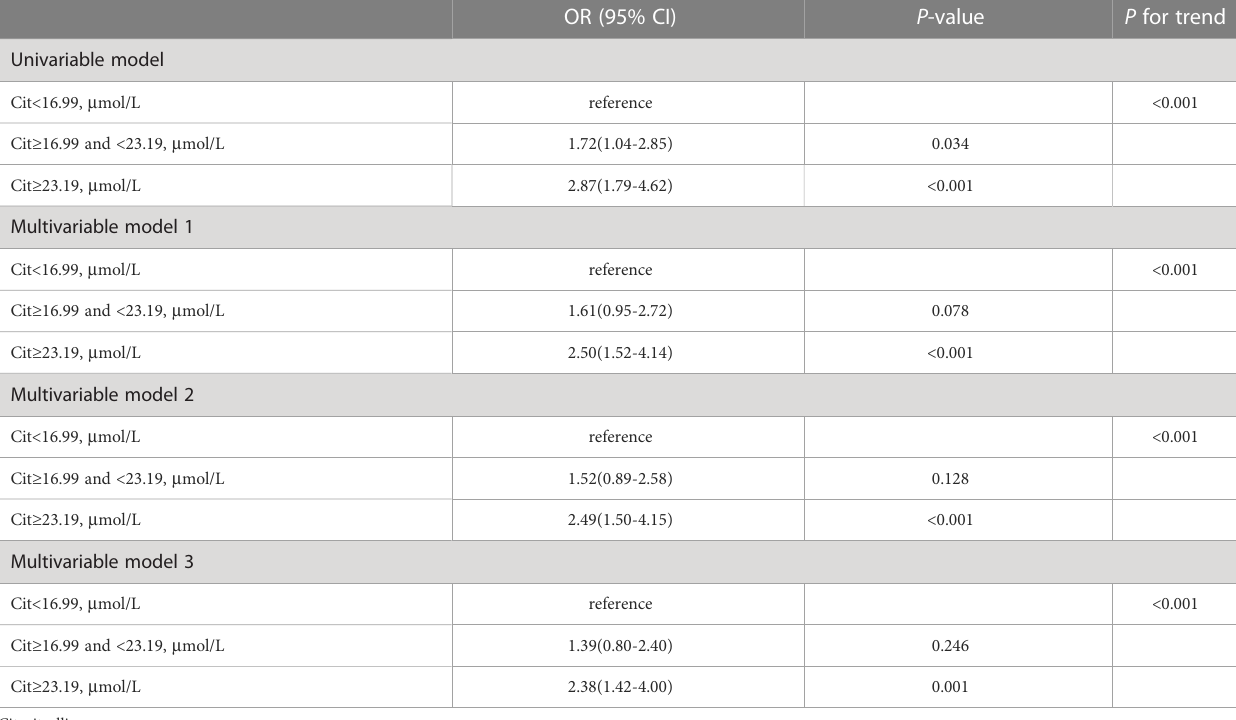
TABLE 3 Odds ratios of cit for the risk of